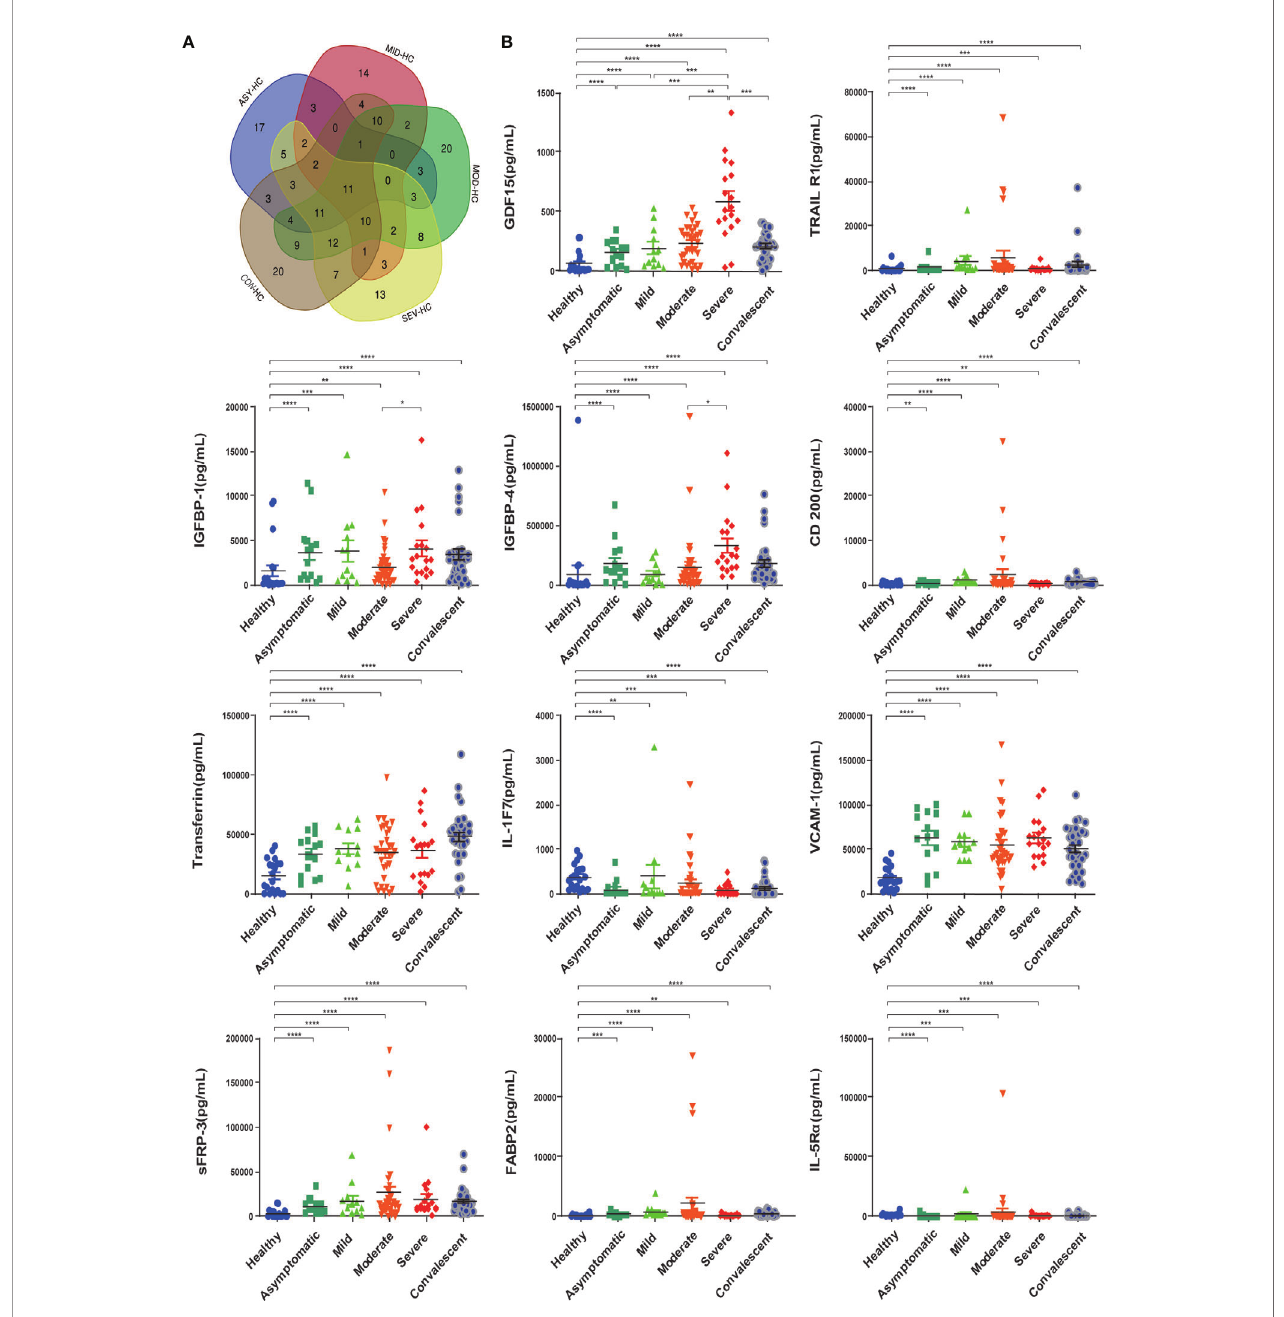
FIGURE 3 | Eleven differentially expressed factors were highly associated with COVID-19 disease severity. (A) Venn diagram displaying the common differentially expressed cytokines in patients with COVID-19 of different severities. (B) Individual levels of the eleven differentially expressed cytokines in different COVID-19 severity groups. Healthy control (n=20), asymptomatic group (n=14), mild group (n=12), moderate group (n=34), severe group (n=18), convalescent group (n=33). Signi fi cance is denoted as * P < 0.05, ** P < 0.01, *** P < 0.001, and **** P < 0.0001. HC, Healthy Control; ASY, Asymptomatic; MIL, Mild; MOD, Moderate; SEV, Severe; CON,